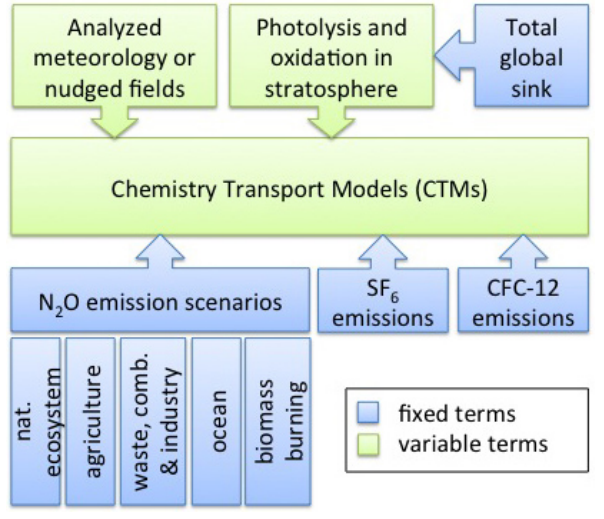
Fig. 1. Schematic of the TransCom-N 2 O modelling